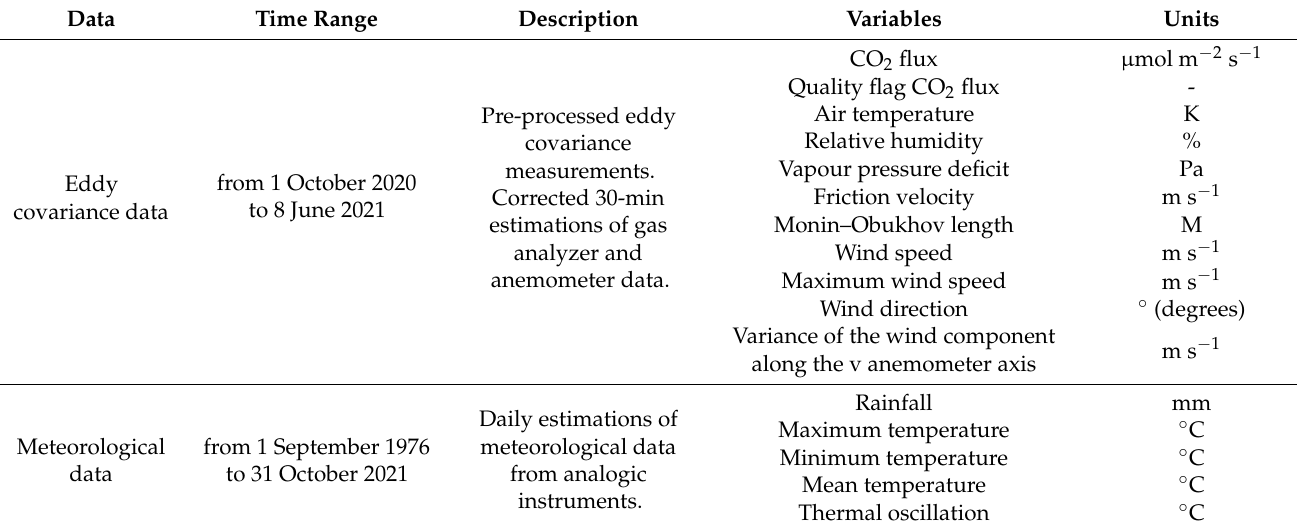
Table 1. Data collected from the ICTS-RBD monitoring system.